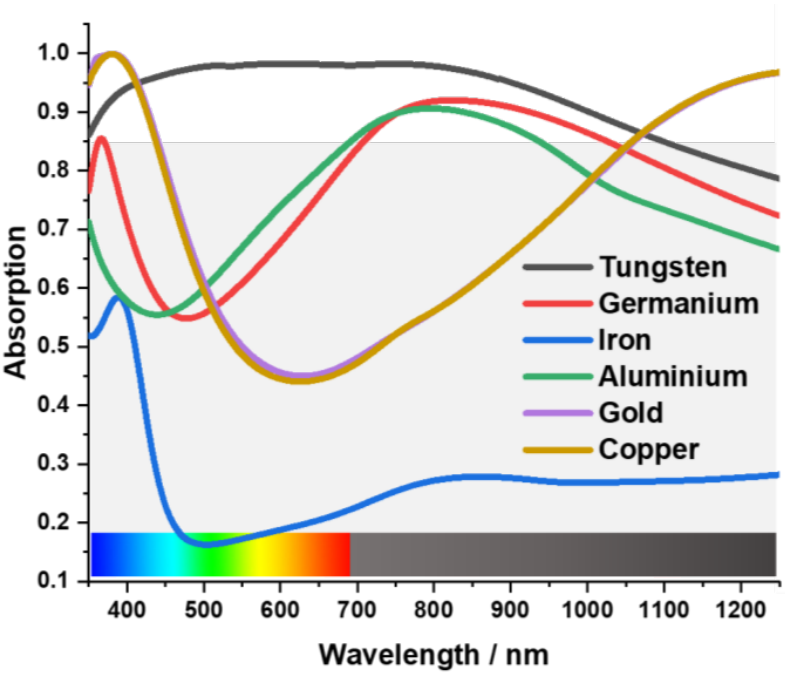
Figure 4. Comparison of different resonating components.